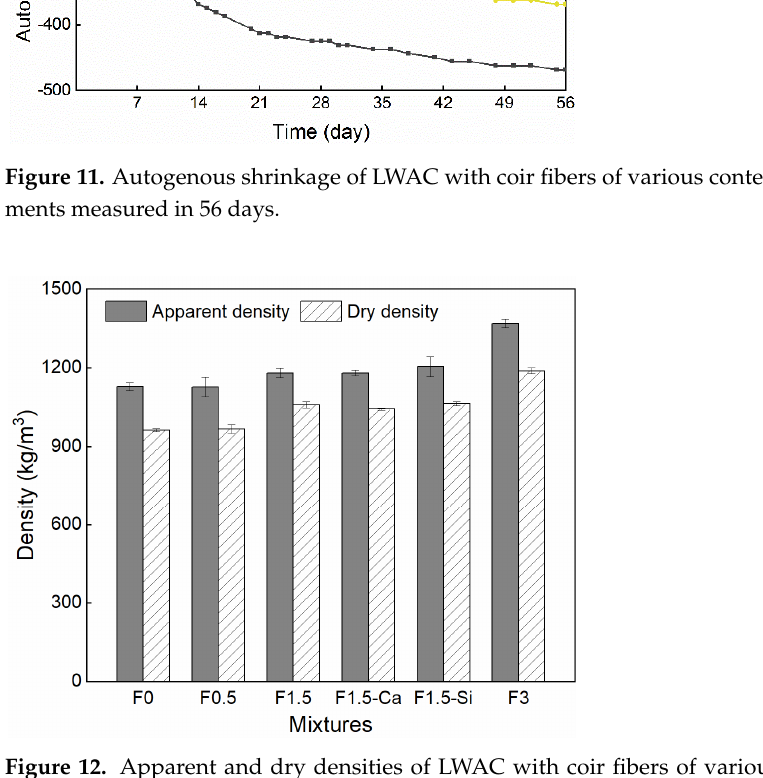
Figure 12. Apparent and dry densities of LWAC with coir fibers of various contents and different treatments.